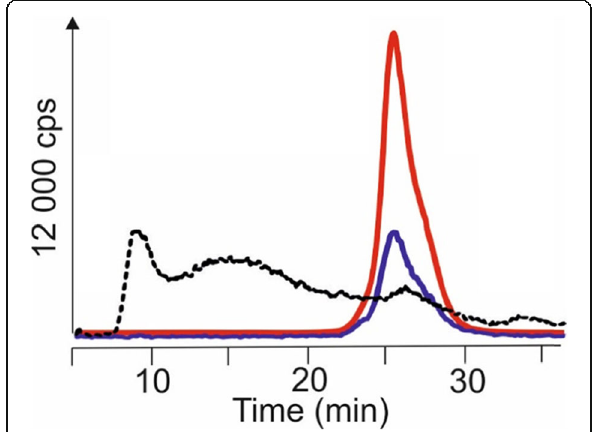
Fig. 2 SEC-ICP-MS chromatograms obtained after sequential extraction of cobalt compounds from goji berries: 1st step — ammonium acetate (red line), 2nd step — tris-HCl (black dots), and 3rd step — SDS (black